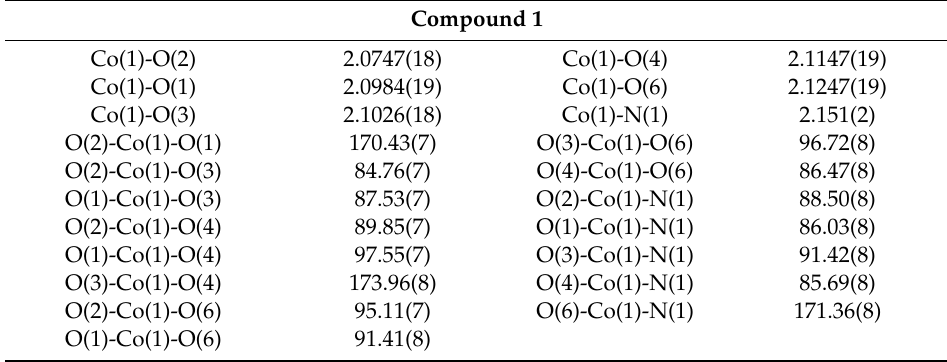
Table 2. Selected bond distances (Å) and angles ( ◦ ) for compound 1 .